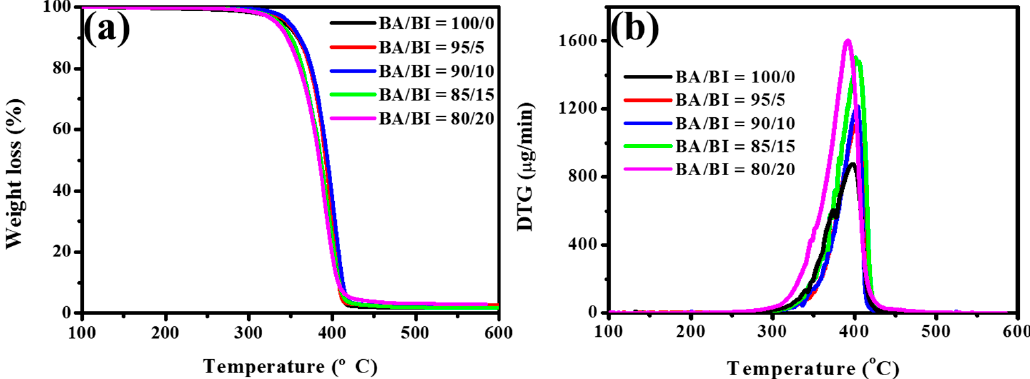
Figure 4. ( a ) Weight loss and ( b ) derivative thermogravimetry (DTG) as a function of temperature of PBABI copolyesters with different BA/BI ratios.